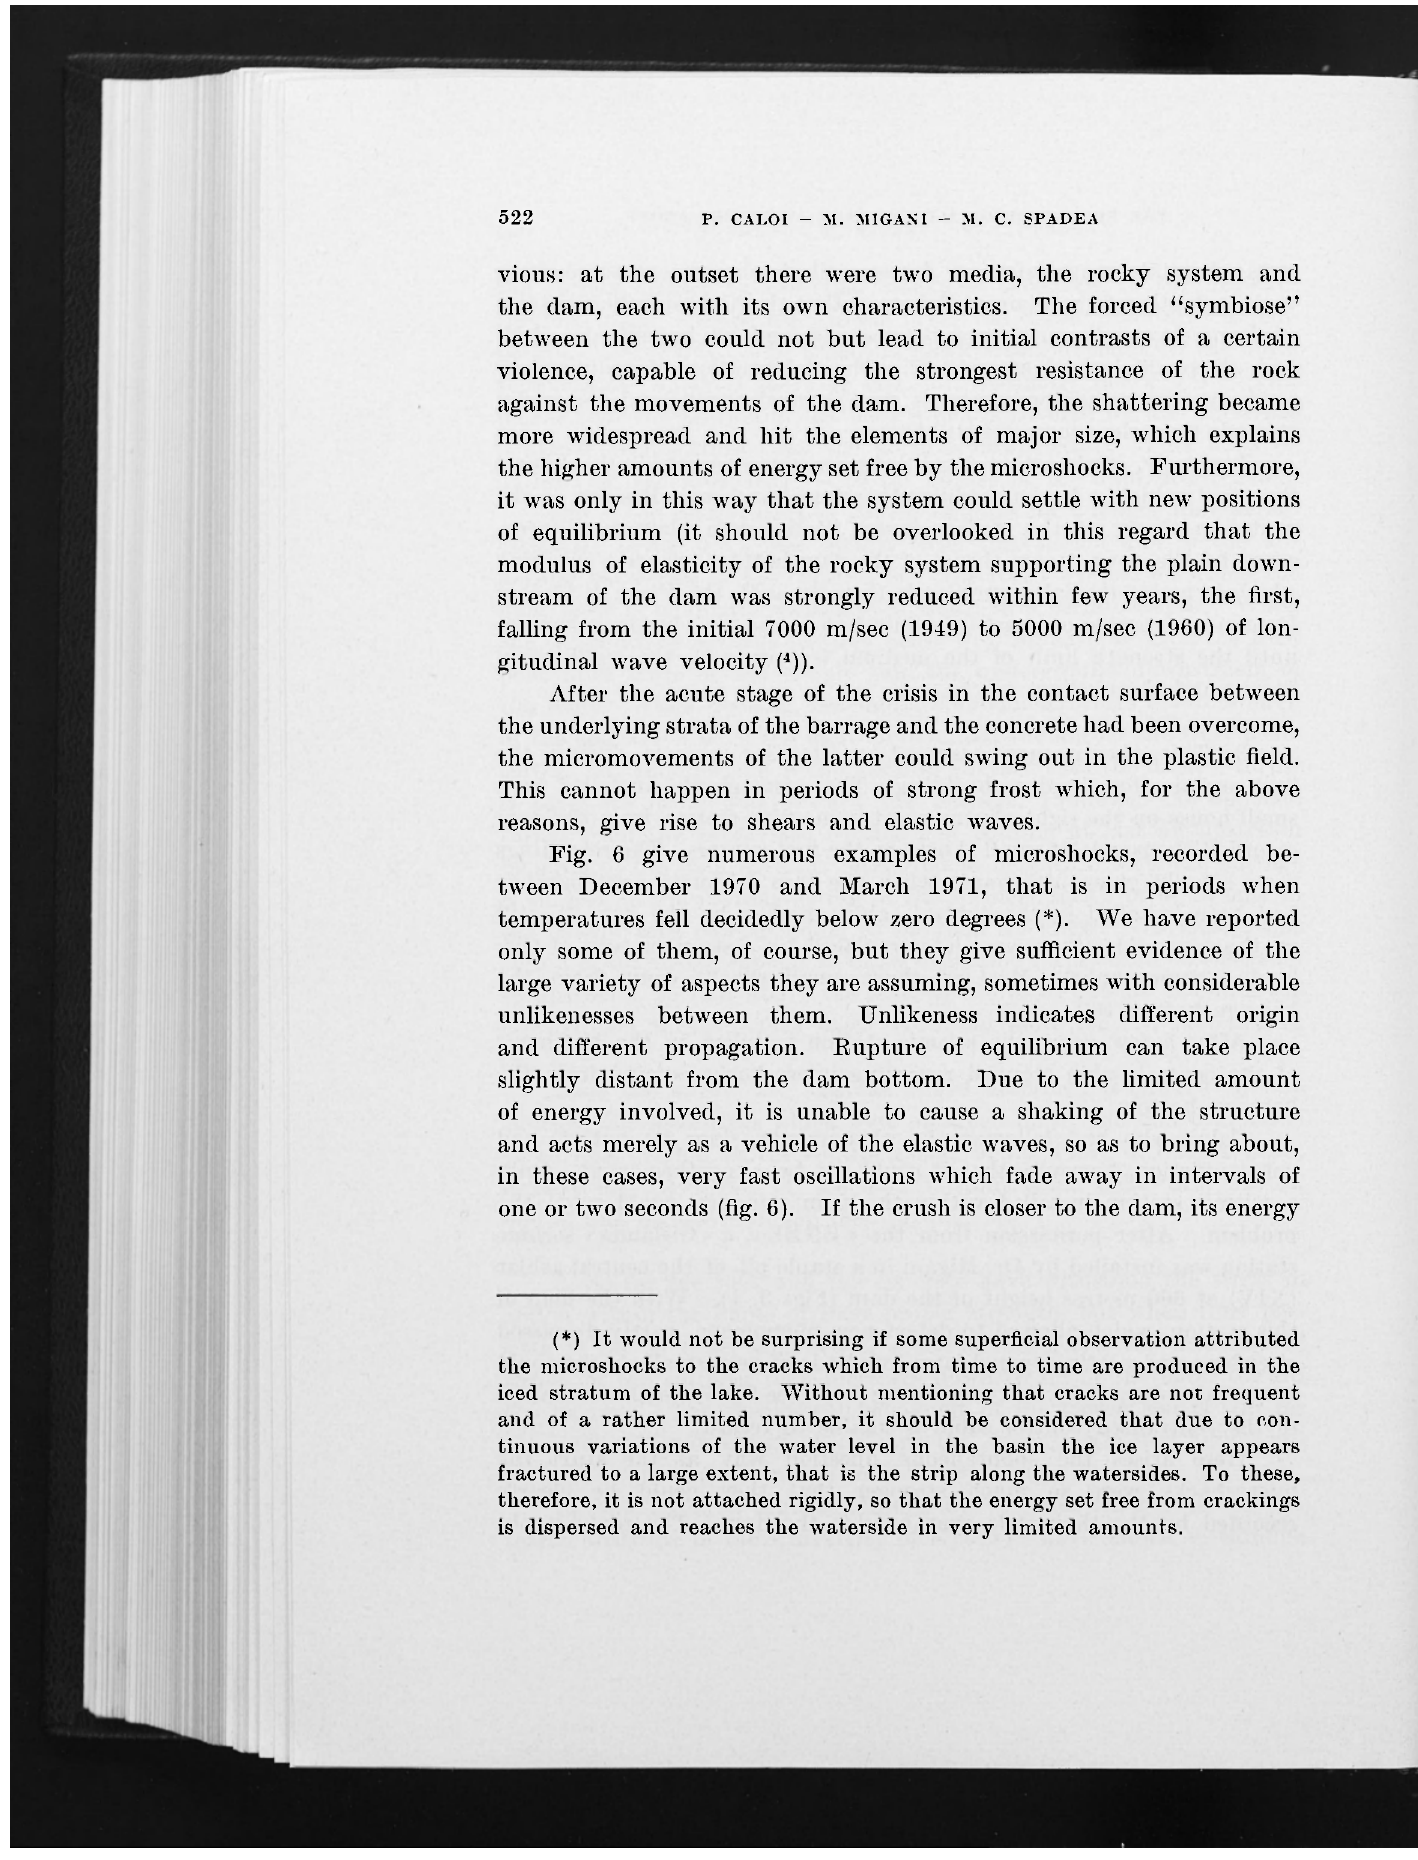
vious: at the outset there were two media, the rocky system and the dam, each with its own characteristics. The forced